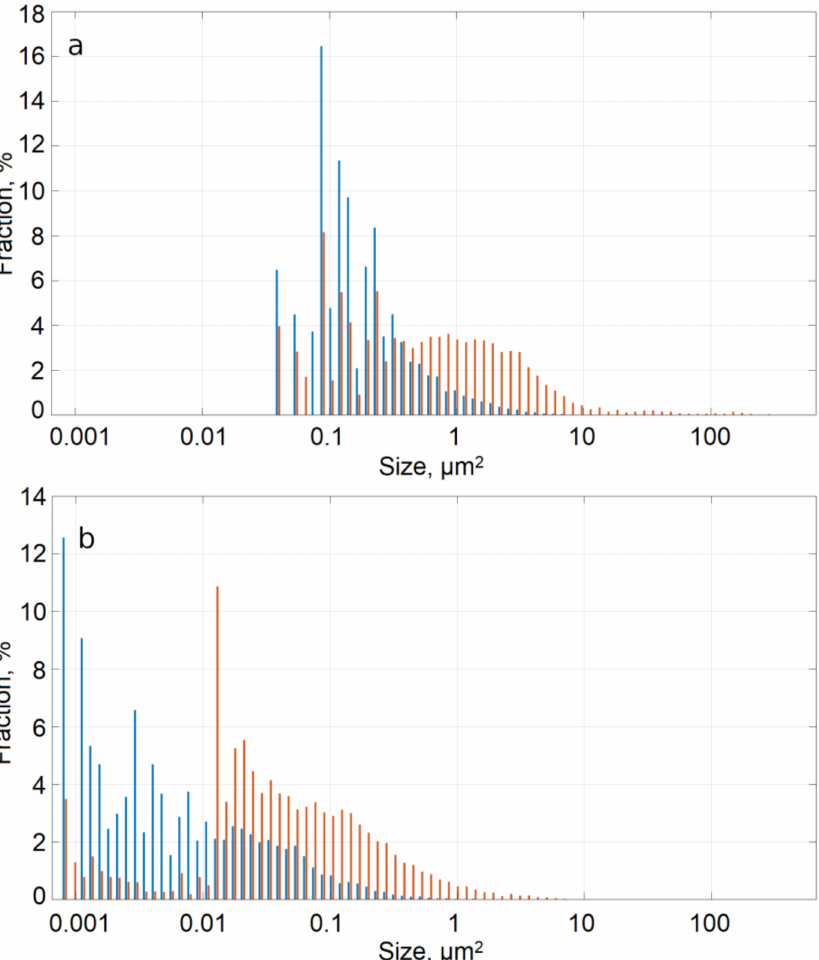
Figure 7. Particle area distribution: ( a ) in as-cast state, ( b ) after HPT. Histogram for Al-2Fe alloy is marked by blue color, for Al-4Fe alloy is marked by orange color. µ m 2